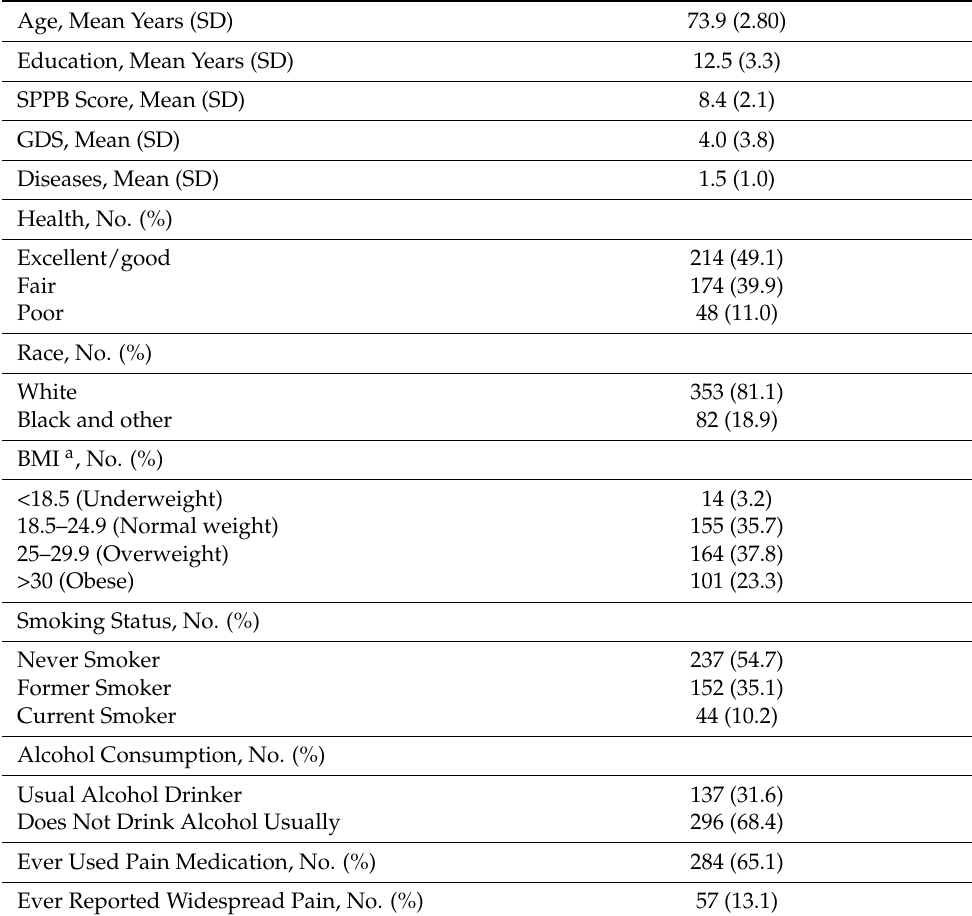
Table 1. Baseline Characteristics in Women’s Health and Aging Study II, Baltimore, Maryland, 1994–2009 ( N = 436).